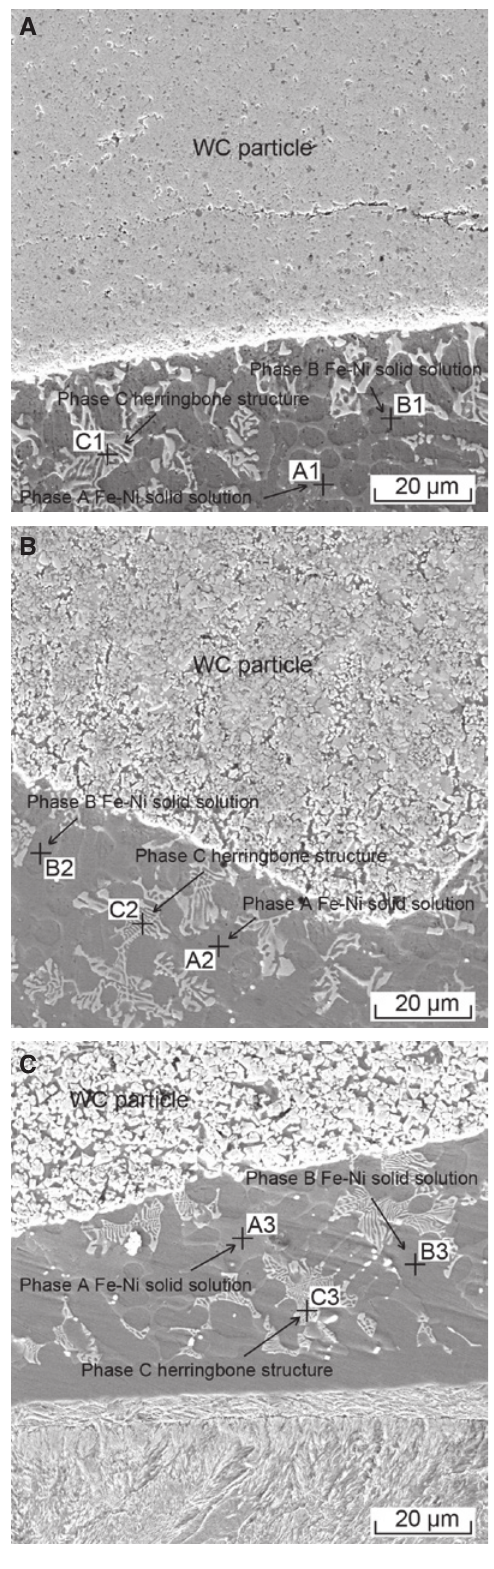
Figure 6: Microstructures of the single-pass specimen in the vicin- ity of a WC particle at the (A) top, (B) middle, and (C) bottom parts of the